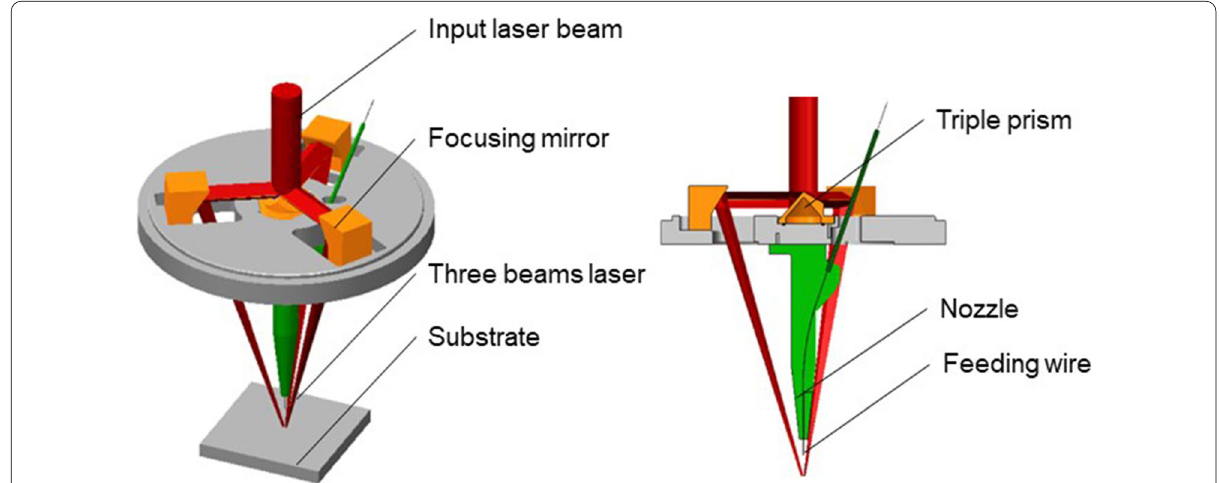
Figure 1 Schematics of three-beam laser with internal coaxial wire feeding cladding head